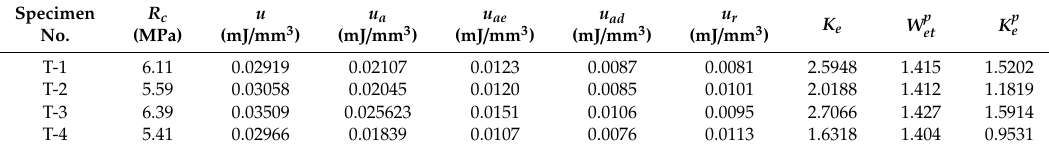
Figure 11. Stress–strain curves of four typical specimens in TJH coal mine. Table 7. Calculated energy parameters for TJH coal mine.